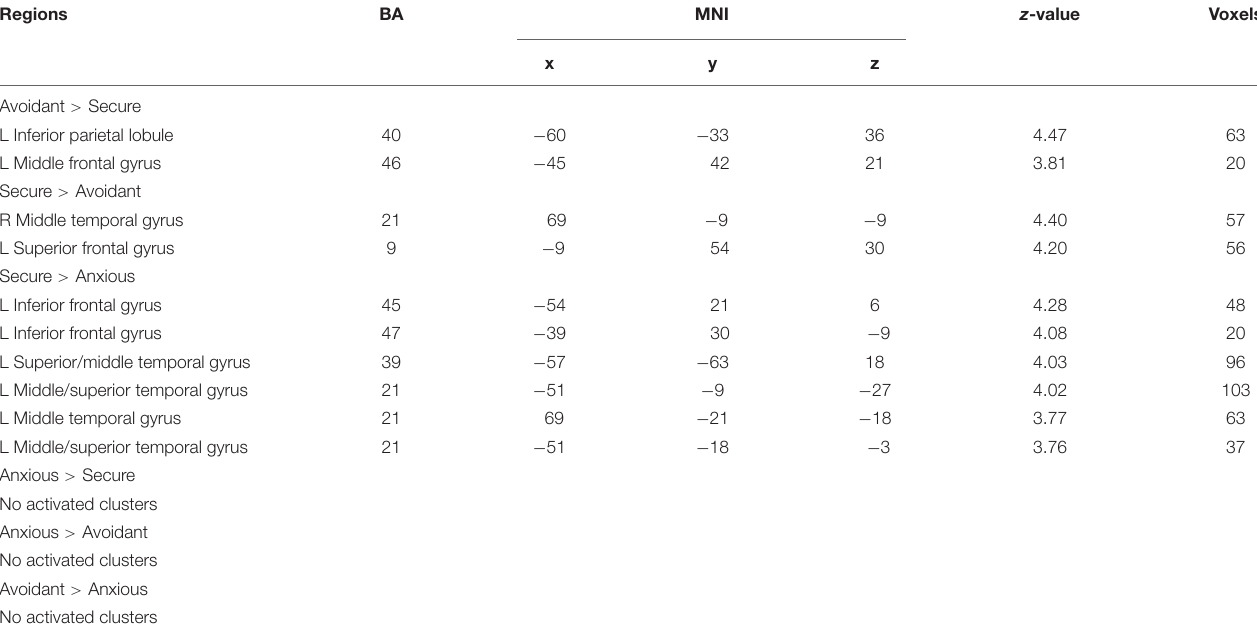
TABLE 4 | Main effect of attachment style.